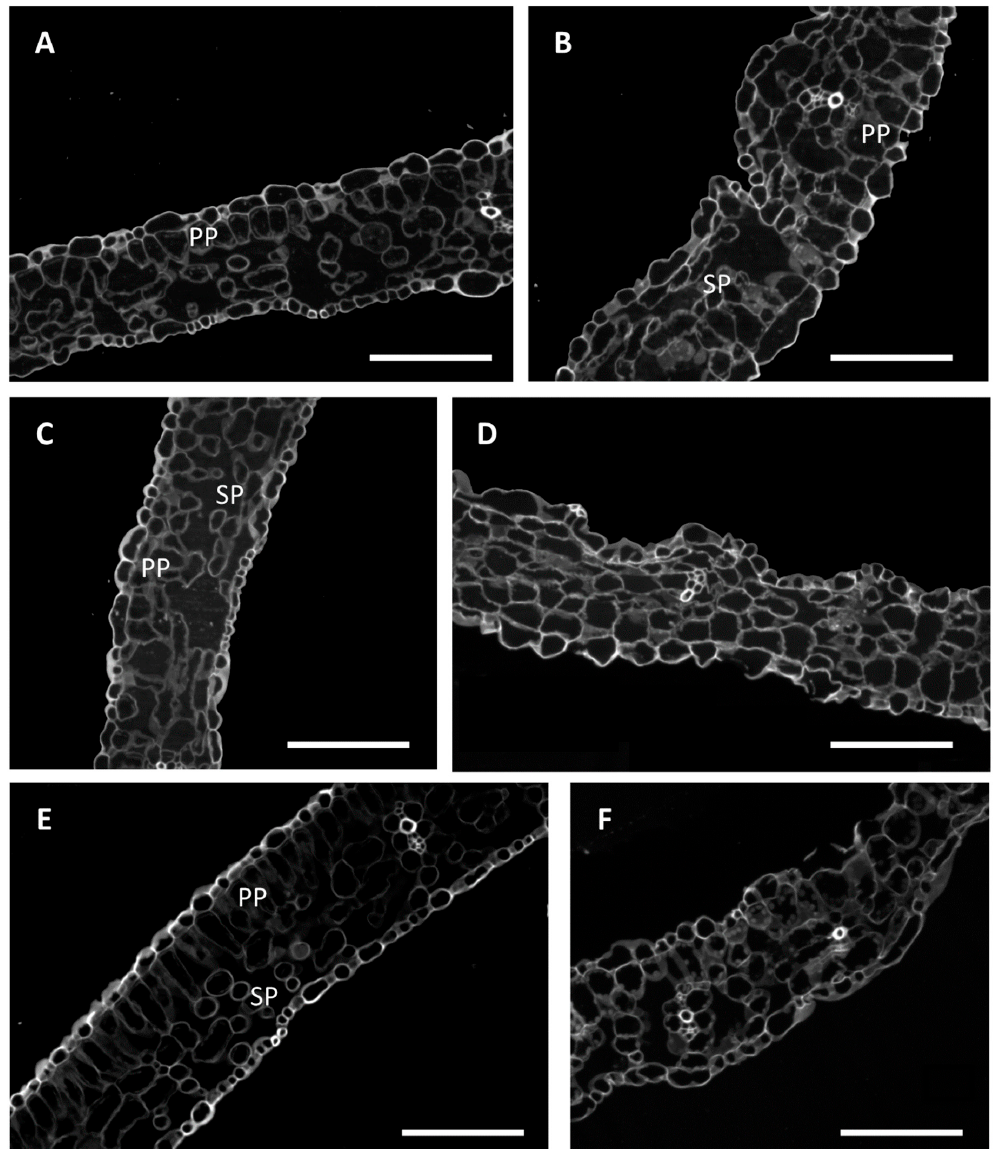
Figure 6. Calcofluor White (CFW) staining in leaves of two local varieties ( A,B —‘Fragola’; C , D —‘Pisanello’) and one commercial cultivar ( E , F —‘Supersteak’). A , C , E are the controls (regularly well-watered plants) and B , D , F are the stressed (no water for 16 days). PP, palisade parenchyma; SP, spongy parenchyma. Scale bar: 100 µm.